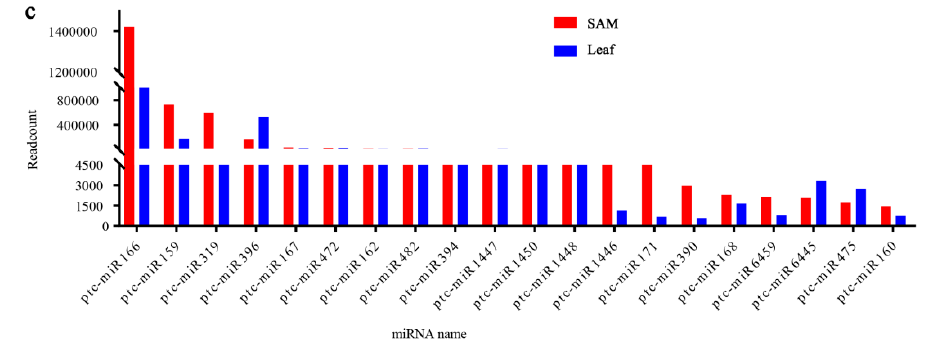
Figure 3. ( a ) Length distributions of the small RNA (sRNA) sequences. ( b ) Number of members within the top 20 known miRNA families. ( c ) Read counts corresponding to the top 20 known microRNA (miRNA) families.